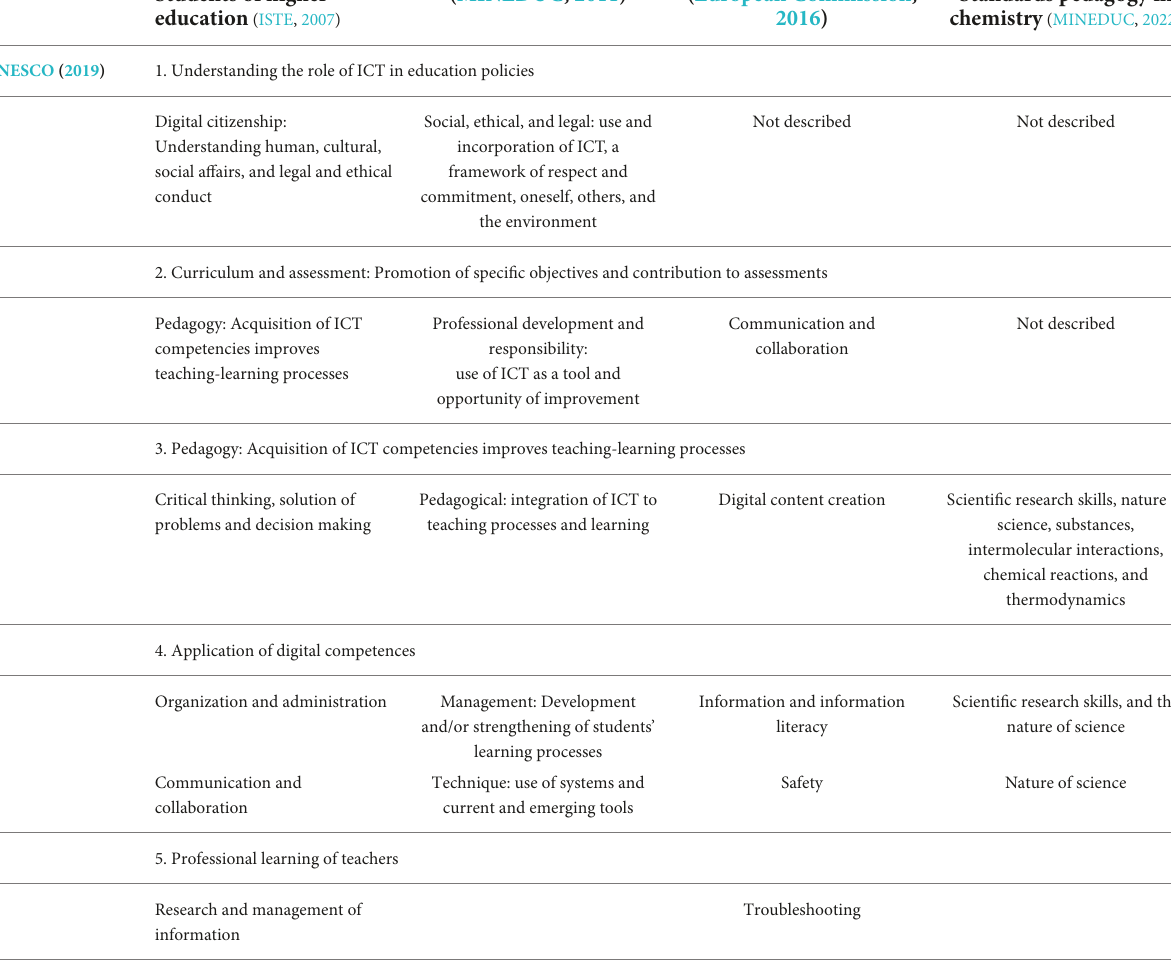
TABLE 3 Description of the UNESCO dimensions around the teacher training frameworks and standards that include digital skills. Students of higher education (ISTE,